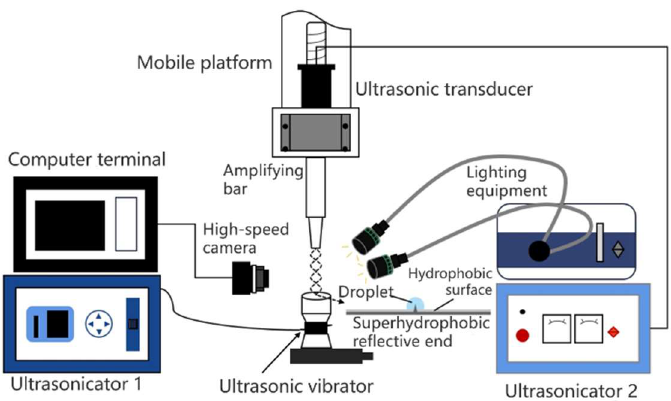
Figure 10. System principle of Compound acoustic fields. Equipment manufacturers and parameters are shown in Table 2 below: Table 2. Equipment, Manufacturer, Model and Parameter Configurations.